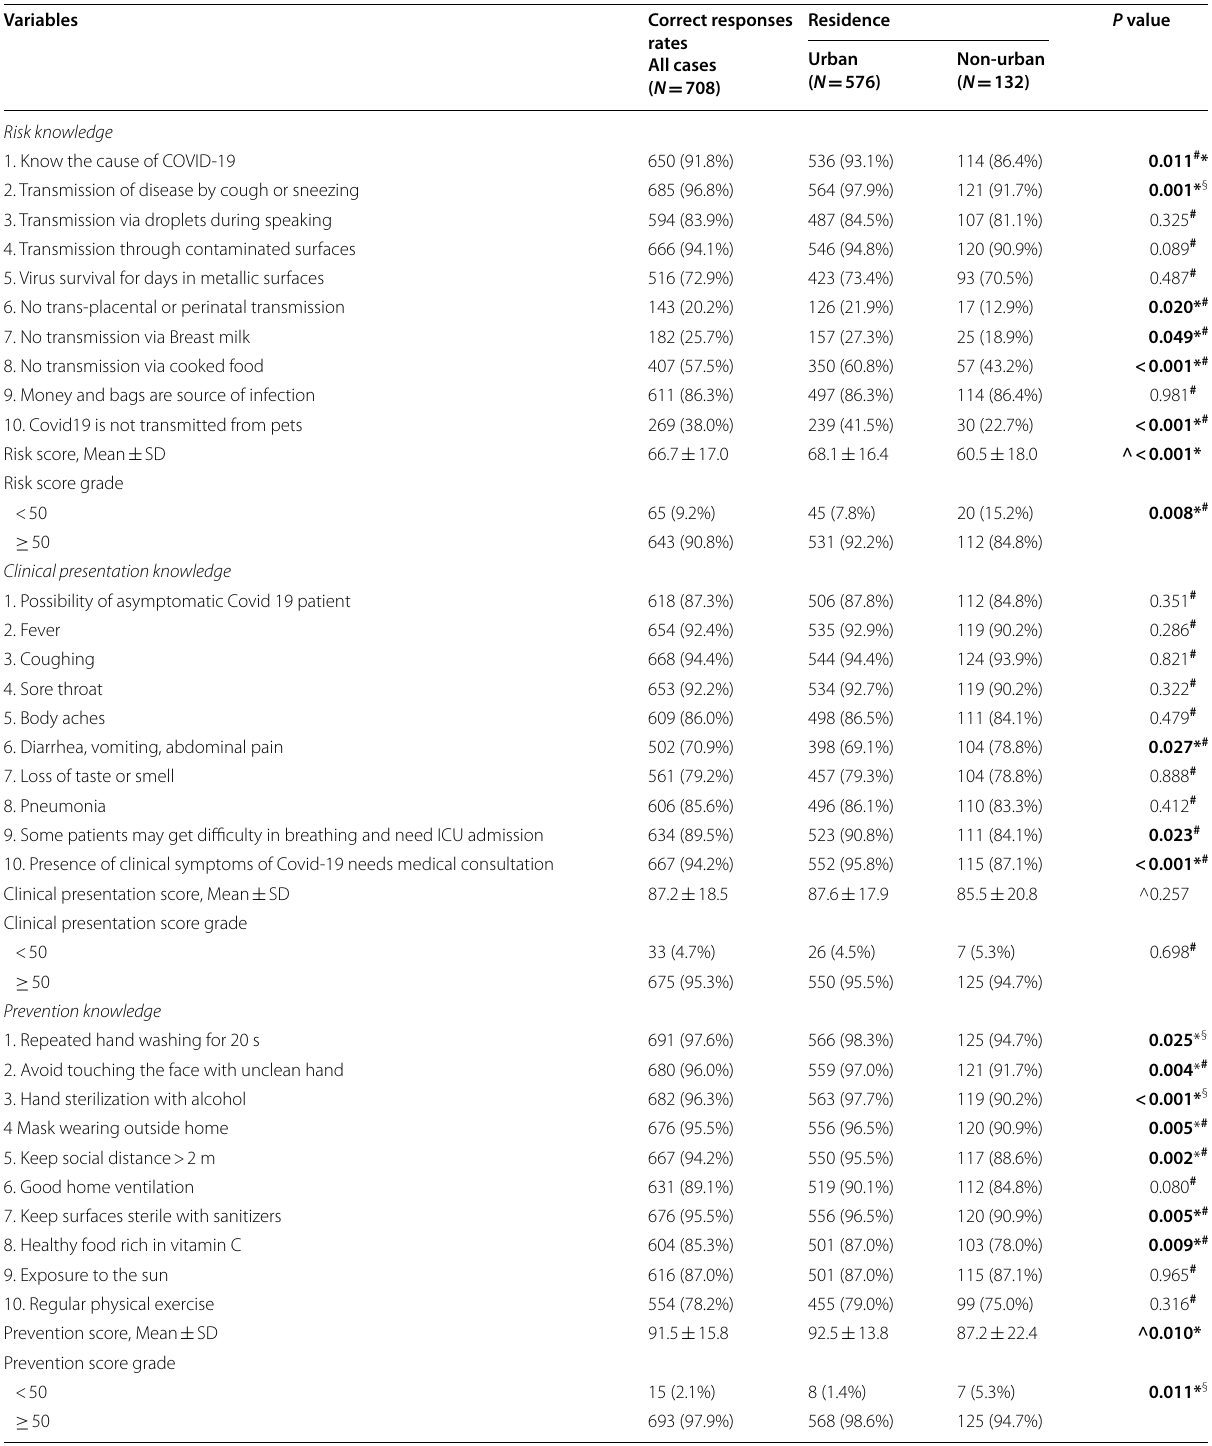
Table 2 Knowledge (risk, clinical presentation and prevention) among the studied cases and according to